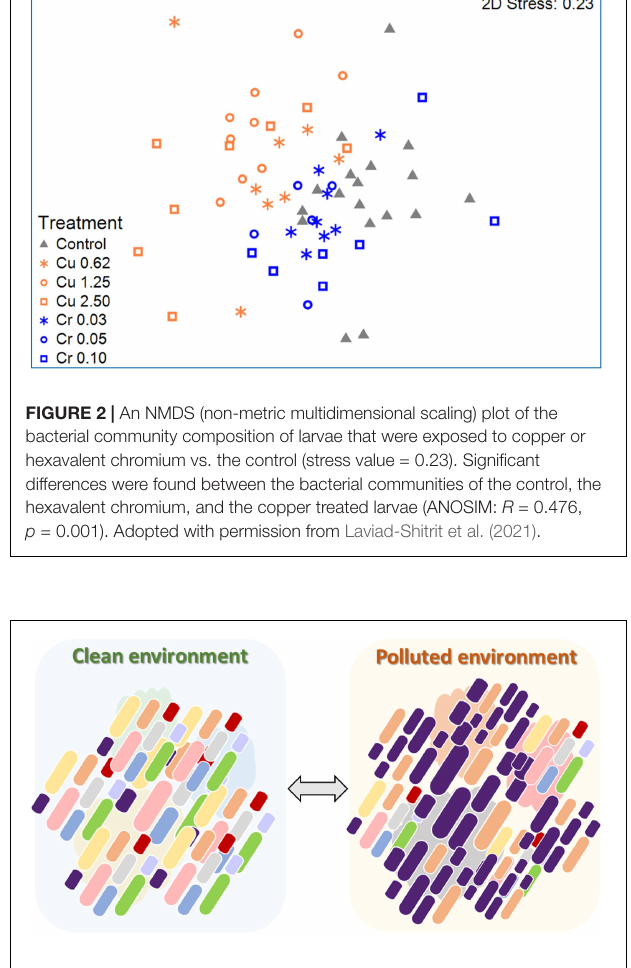
FIGURE 3 | The change in the chironomid larval microbiome composition after exposure to a polluted environment. In an unpolluted environment, the diversity of the larval microbiome is relatively high. The microbiota composition contains a collection of bacterial species with different potential abilities (left). When pollution is introduced into the aquatic environment, specific bacterial species in the larval microbiome, with the potential ability to detoxify the pollutant, will relatively proliferate and protect the host under the stressful conditions (right). As a consequence, the diversity of the larval microbiome will be reduced compared to the unpolluted environment. This procedure is bidirectional, meaning that when the environment becomes cleaner, the diversity of the larval microbiome will increase